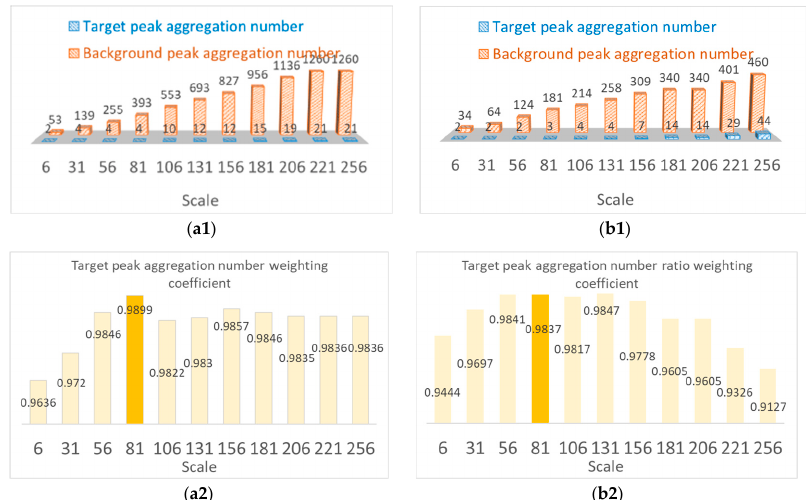
Figure 10. The number of target/background peak aggregation and the weighting coefficient of target peak aggregation in different scale windows. ( a1 ) Peak aggregation number of image A. ( a2 ) Weighted coefficient of target in image A. ( b1 ) Peak aggregation number of image B. ( b2 ) Weighted coefficient of target in image B.